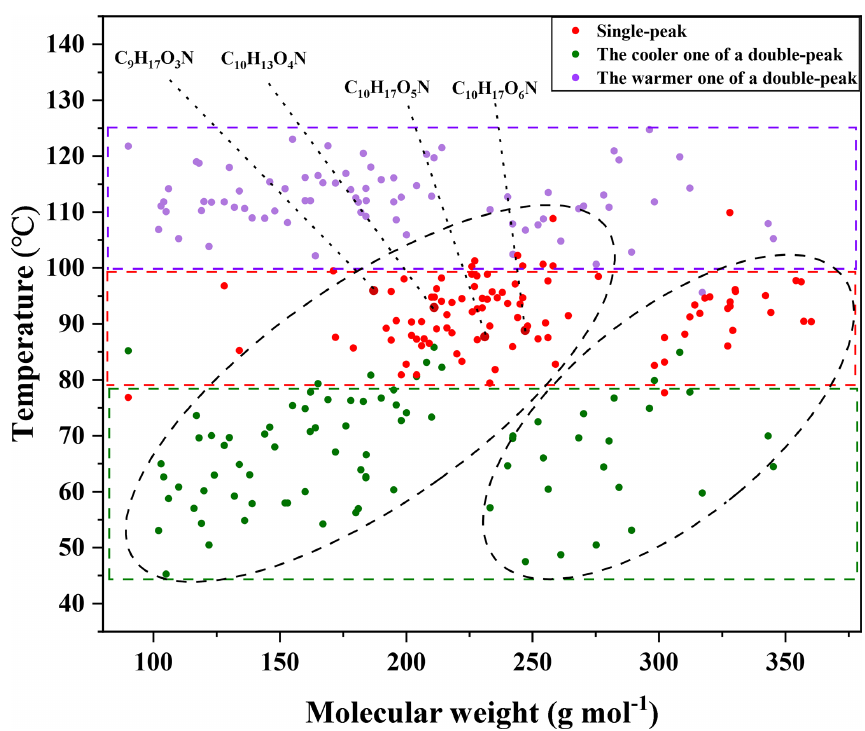
Figure 3. Evaporation and decomposition of 91 CHO and 90 CHON compounds, of which the reagent ion (I − ) is excluded from their formulae. The signal peaks, the cooler peaks, and the warmer peaks of double peaks are denoted by red, green, and purple circles, respectively. Rectangular bands depict the temperature zones in which peaks